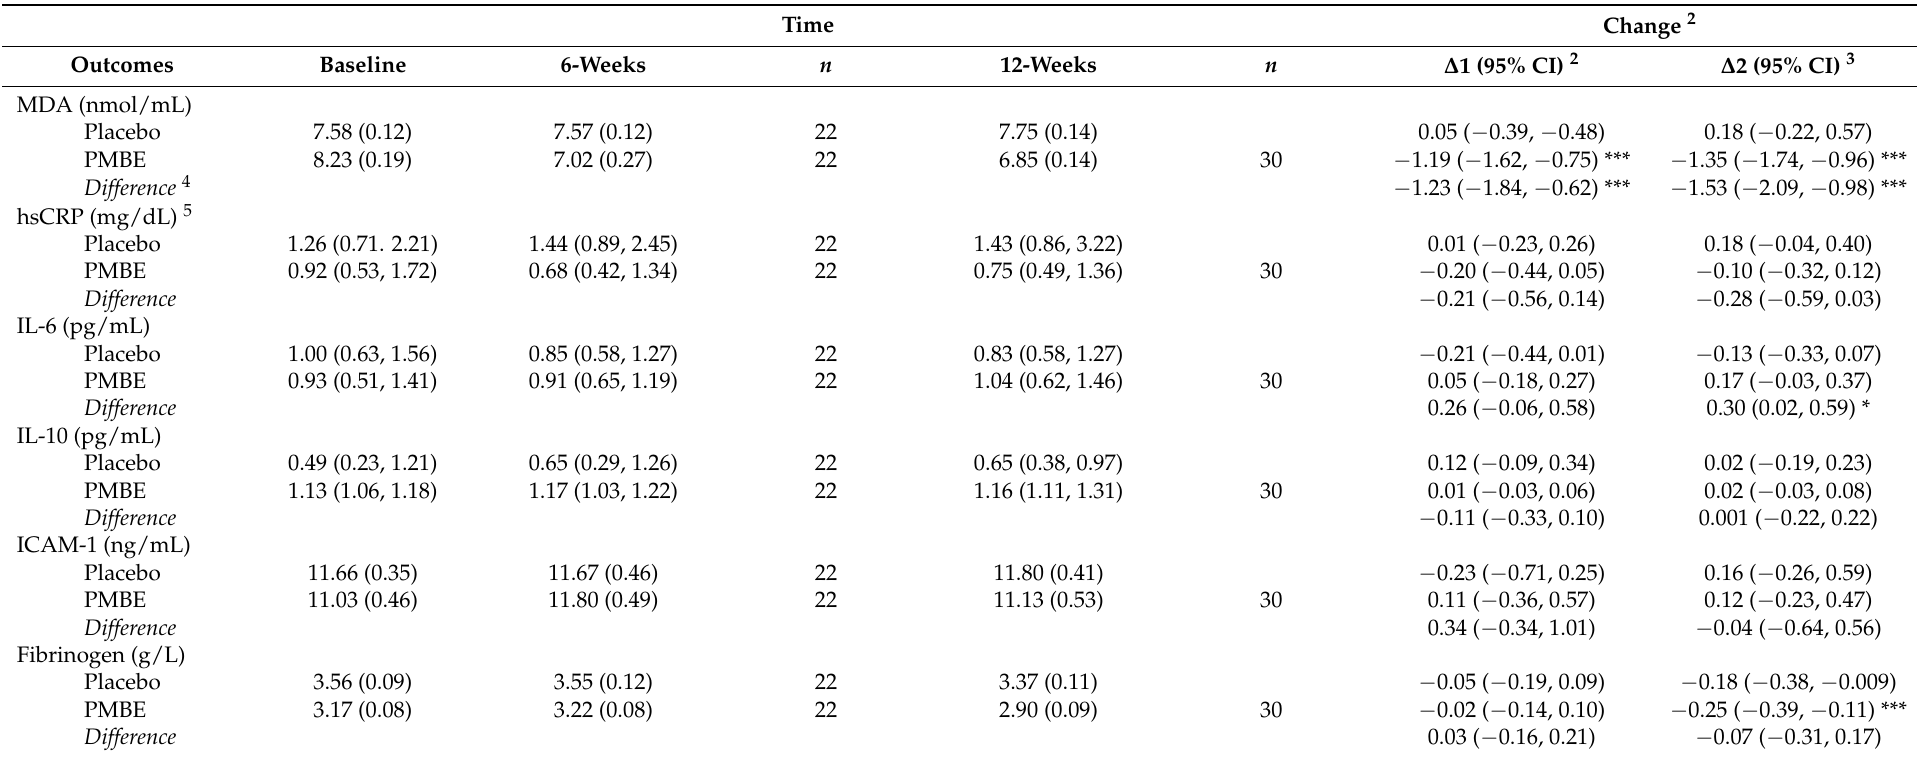
Table 4. Biochemical parameters in the placebo group and PMBE group at baseline, 6 weeks and 12 weeks (post-intervention) and changes in biochemical parameters from baseline at 6 weeks and 12 weeks 1 .